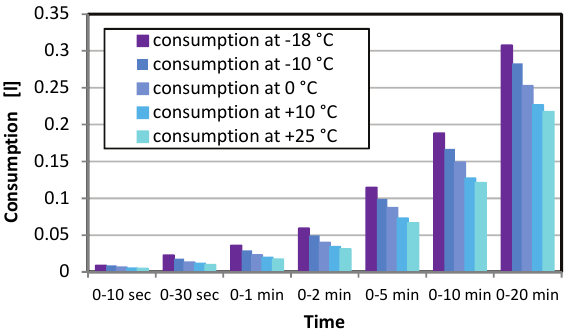
Fig. 2. The amount of fuel consumed by FIAT Doblo (CI) The Instantaneous fuel consumption [l/h] as a function of time for selected temperatures has been shown in Figs 3–5.